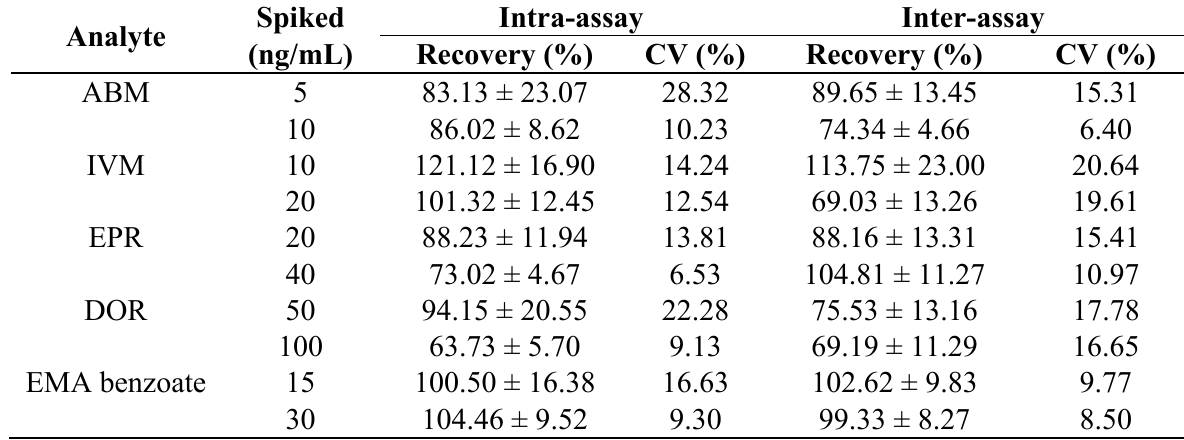
Table 4. Recoveries of AVMs from spiked milk samples with simple dilution preparation (n = 4). Analyte